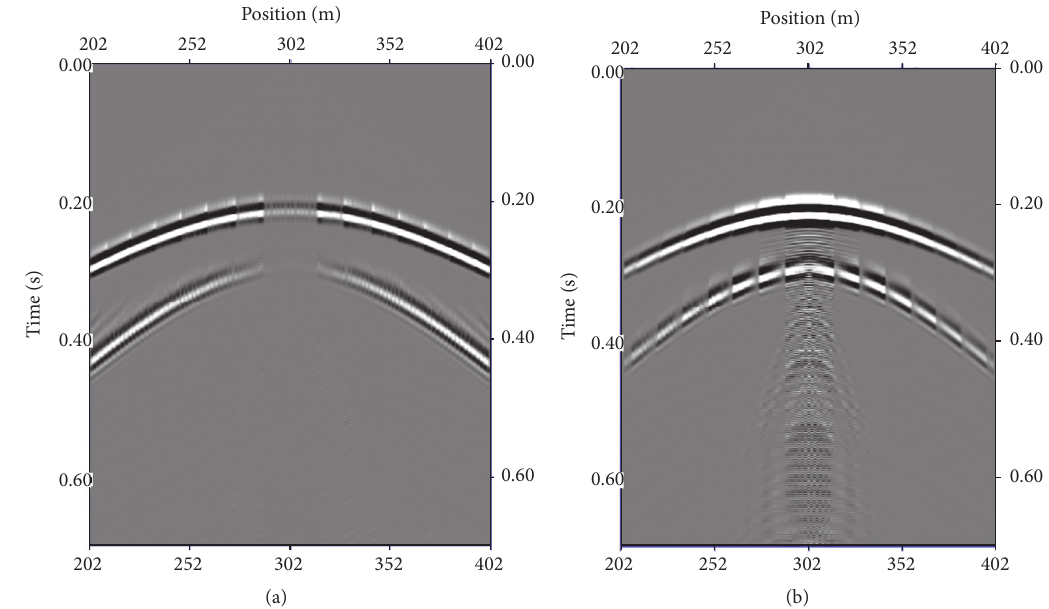
Figure 8: The extracted CSP gather: (a) the CSP gather at the scatter point using the algorithm for horizontal surface assumption; (b) the CSP gather at the same scatter point using the algorithm for the rugged surface.